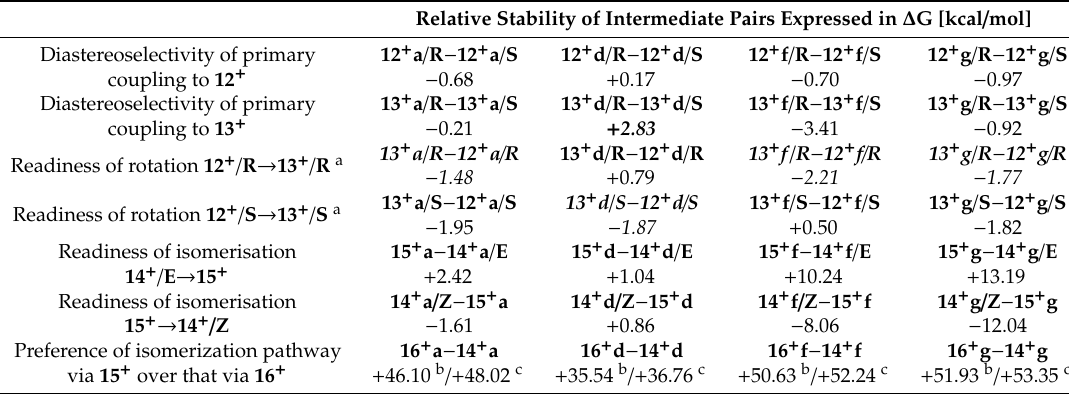
Table 3. Relative stability of selected isomer pairs to rationalize of the substituent- and time-dependent interconversion of cis - and trans -pentacycles 8 / C1 and 8 / T1 , as resulted from DFT modeling studies. Relative Stability of Intermediate Pairs Expressed in ∆ G [kcal / mol] Diastereoselectivity of primary coupling to 12